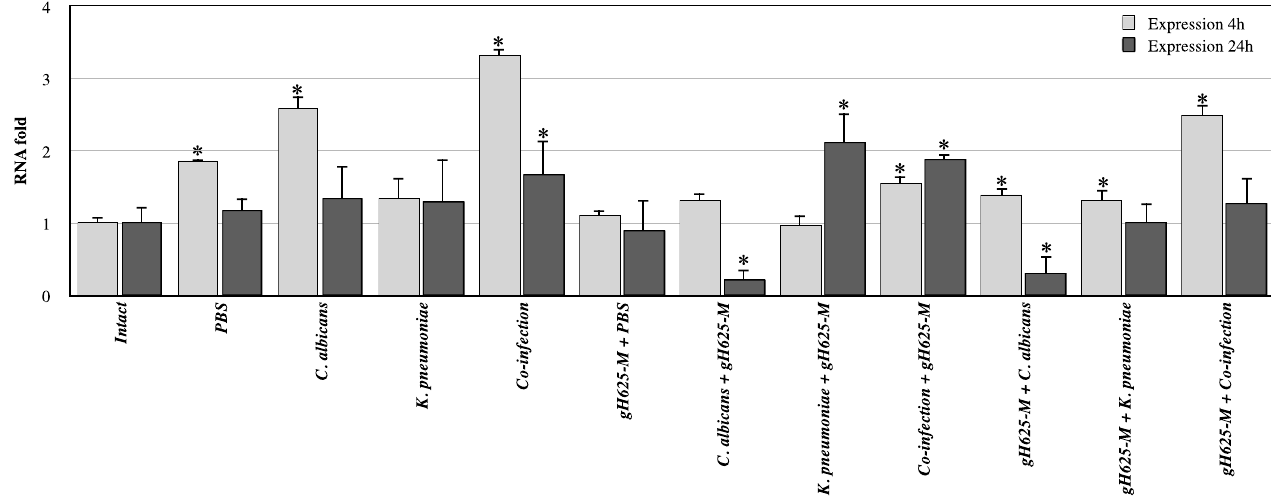
Figure 6. Relative mRNA expression levels of galiomycin gene in G. mellonella larvae infected with C. albicans and K. pneumoniae alone or together and pre-treated or post-treated with gH625-M, at 4 and 24 h, measured using real-time PCR analysis and calculated by the 2 (−ΔΔC(T)) method. Actin gene was used as housekeeping. Each sample was tested and run in duplicate. No-template controls were included. * asterisk indicates that the difference vs. intact larvae expression is statistically significant (Wilcoxon two group test, p < 0.05). Error bars represent the SEM.